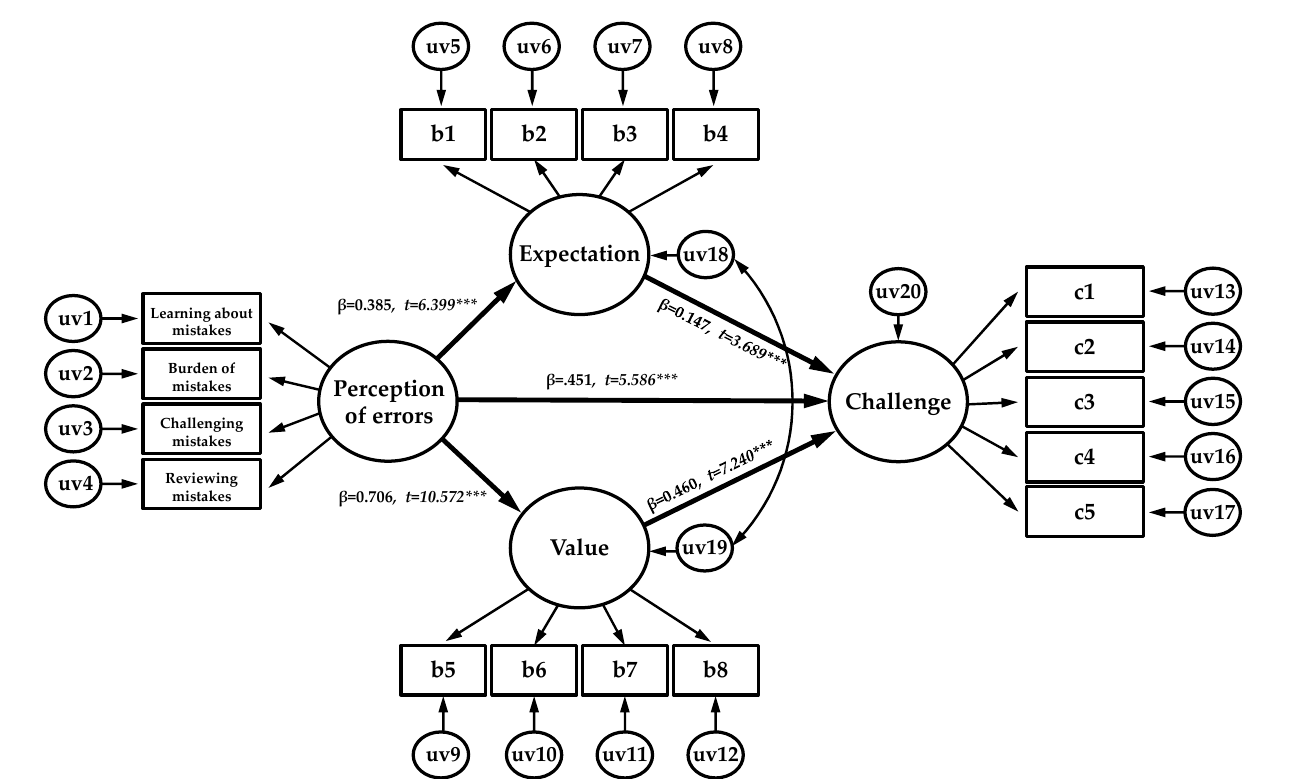
Figure 2. Structural equation modeling (SEM) analysis results. χ 2 = 238.885, df = 98, TLI = 0.959, CFI